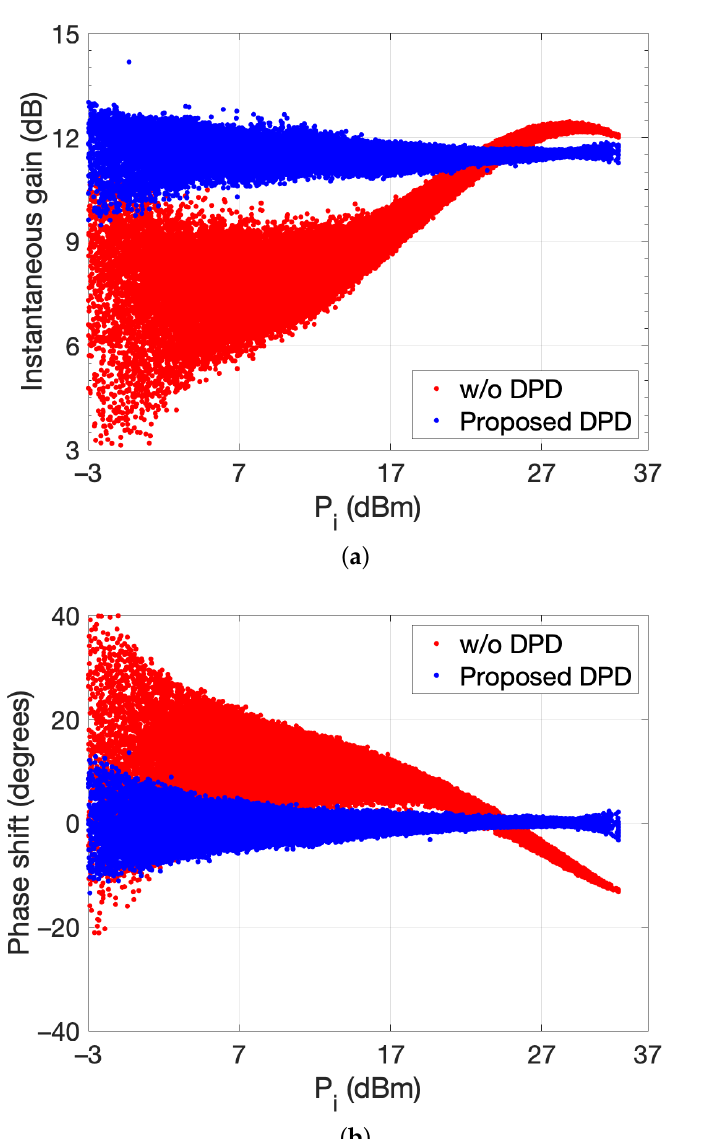
Figure 14. RF dynamic ( a ) gain and ( b ) AM/PM characteristics of the class J PA operated near satura-